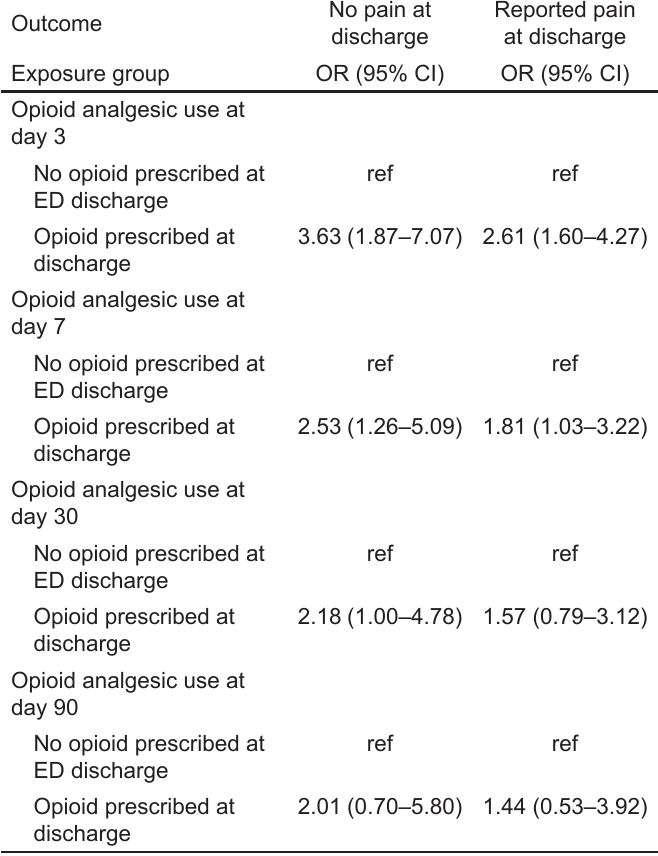
Table 2. Odds ratios of using an opioid analgesic at each post- emergency department (ED) visit follow-up by reported pain at the end of the ED visit and receipt of prescription opioid analgesic from the ED. Estimates from multivariable model weighted for propensity to receive an opioid analgesic prescription at ED discharge and using multiple imputations with chained equations to account for missing outcome data at